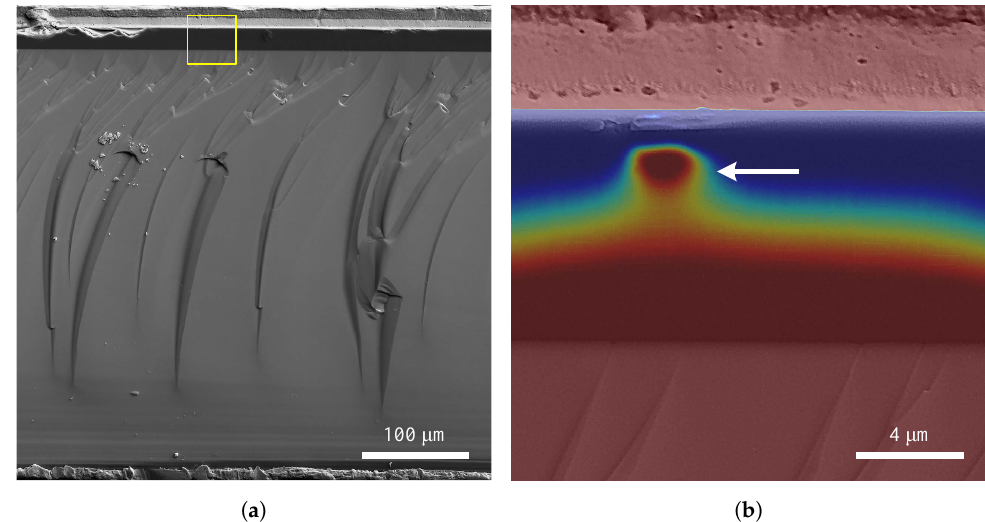
Figure 12. The images show cross-sectional view of the GaAs PV cell on a SEM microscope. The image ( a ) shows the complete structure of the PV cell. Contacts are visible from below and from top (contact is longitudinal along the edge). The largest part of the picture is occupied by germanium. However, the most important are the thin layers (the darkest part). The image ( b ) on the right represents the part marked with a yellow rectangle in image ( a ). The colored EBIC method ( b ) is used to visualize the distribution of carriers in the pn junction area. There is also applied bias voltage of − 1mV. Impurity (pointed by arrow), which was probably contaminated during the fabrication, is electrically active and allows easier tunneling of electrons through the junction